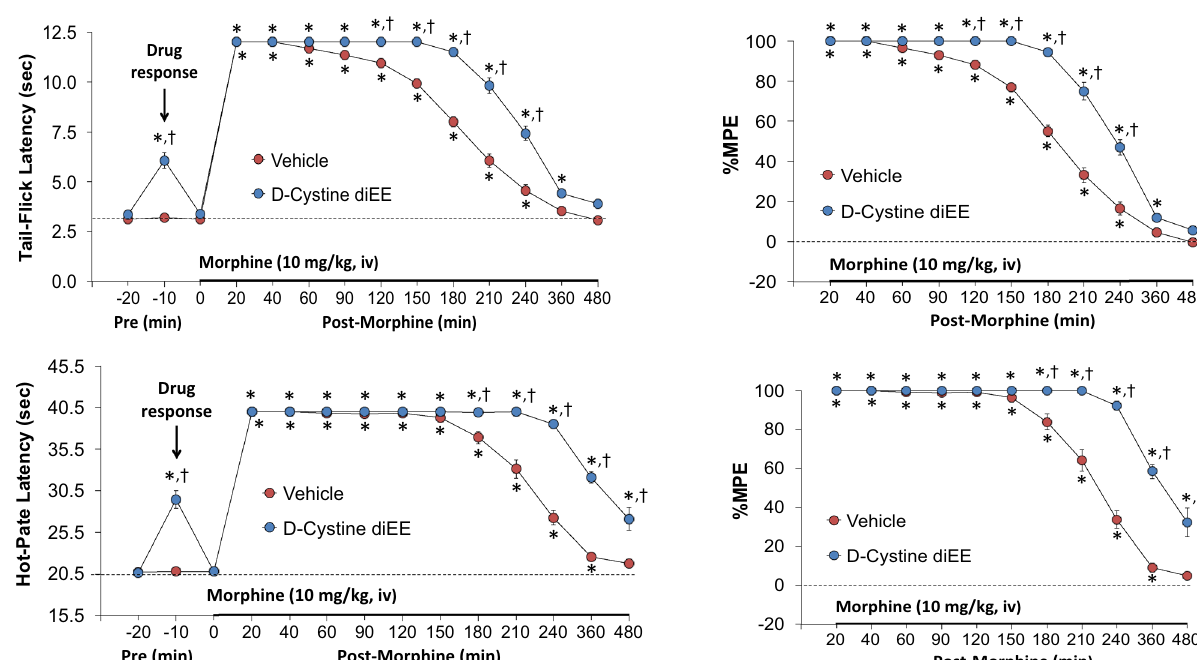
Figure 7. Changes in tail-flick latency (top panel) and hot-plate latency (bottom panel) elicited by injection of vehicle (VEH, saline) or d-cystine diethyl ester (d-cystine diEE, 500 μmol/kg, IV) and a subsequent injection of morphine (10 mg/kg, IV) in freely moving rats. The left-hand panels show actual data whereas the right-hand panels display the data as maximum possible effect (%MPE). The data are shown as mean ± SEM. There were 9 rats in each group. *P < 0.05, significant change from Pre. † P < 0.05, d-cystine diEE versus